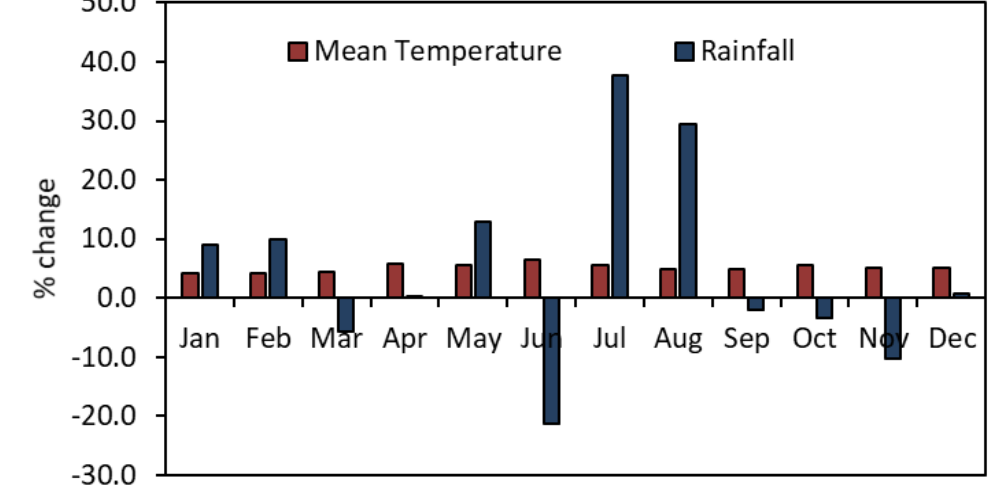
Figure 6. Projected change in monthly rainfall and mean temperature by 2040 .